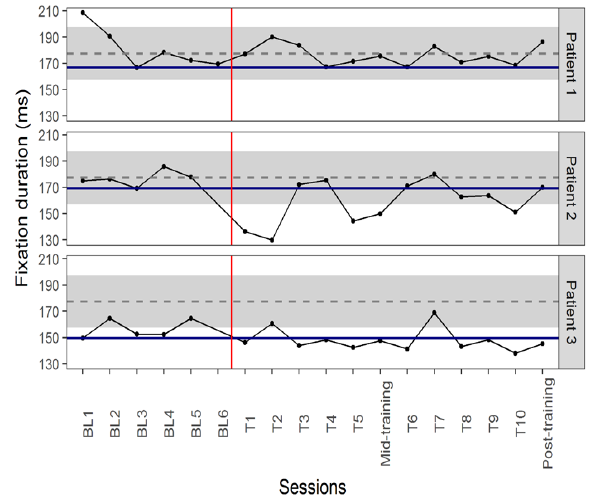
Figure 4: Fixation duration (FD: ms) changes during the baseline and training sessions. Solid blue line represents the shortest baseline value for each patient. Grey dashed lines and grey backgrounds show the mean ± standard deviations of FD in healthy non-gamer participants. The red vertical line separates baseline and training periods. BL= baseline,